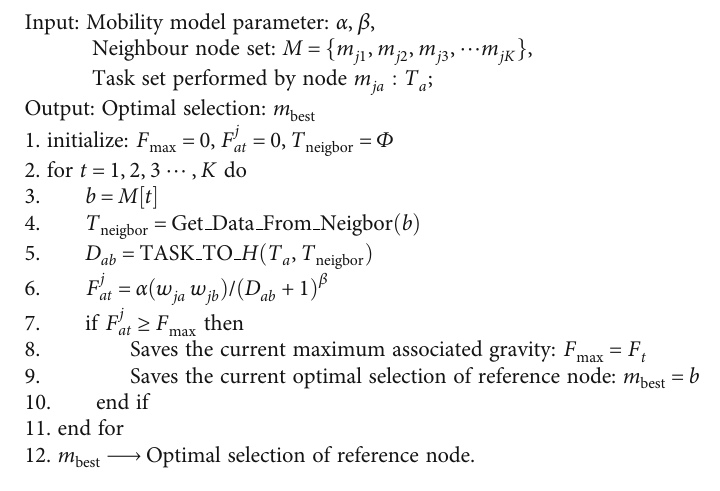
Algorithm 1: Reference node selection for node m ja Figure 8 is a schematic diagram for the ML-RNGM model. The fi gure just illustrates the movement of nodes in two clusters from time t to time t + 1 . According to the net- working topology, there are two cluster heads and one cen- tral controller which is selected out as the physical reference central controller. Di ff erent symbols represent dif- ferent node types, such as round for the normal node, square for the cluster node, and pentangle for the central controller node. Additionally, di ff erent colors and styles of arrows stand for di ff erent relationships, such as the red arrow shows the motion vector of nodes, the black arrow is the motion vector of the central controller, the green dotted line, and the solid line shows the motion vector of the central control- ler, and the purple dotted line shows the reference node motion vector.